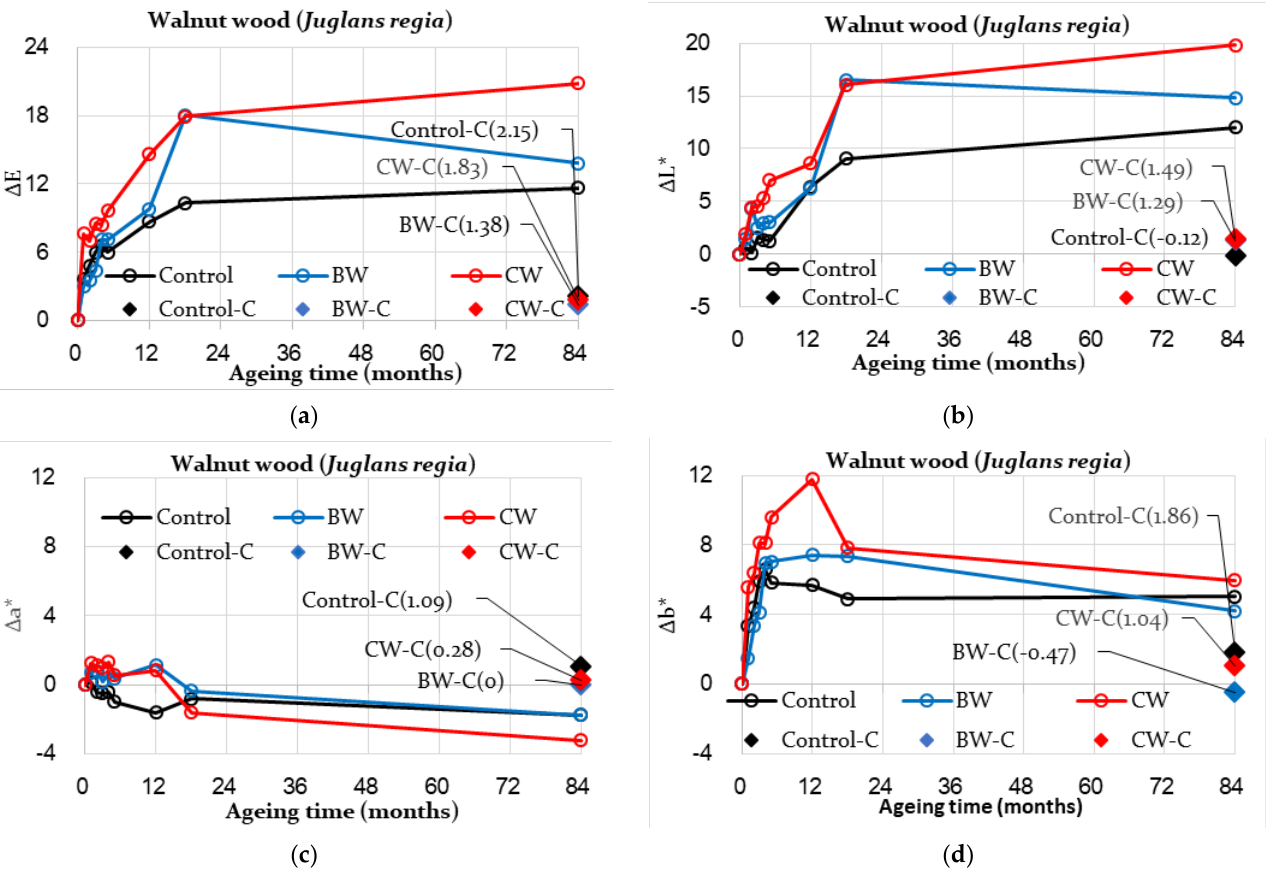
Figure 3. Colour changes for uncoated and coated European walnut wood ( Juglans regia ) samples during natural ageing. ( a ). Global colour changes (ΔE); ( b ). Lightness changes (ΔL*); ( c ). Redness changes (Δa*); ( d ). Yellowness changes (Δb*). Codes ending with -C represent comparative data for the covered surfaces at the end of the test (7 years).